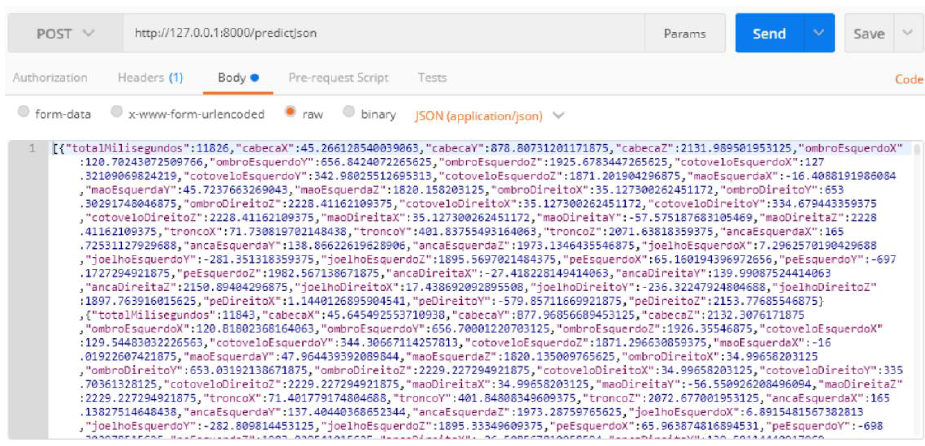
Table 4. Summary of HTTP Inference response